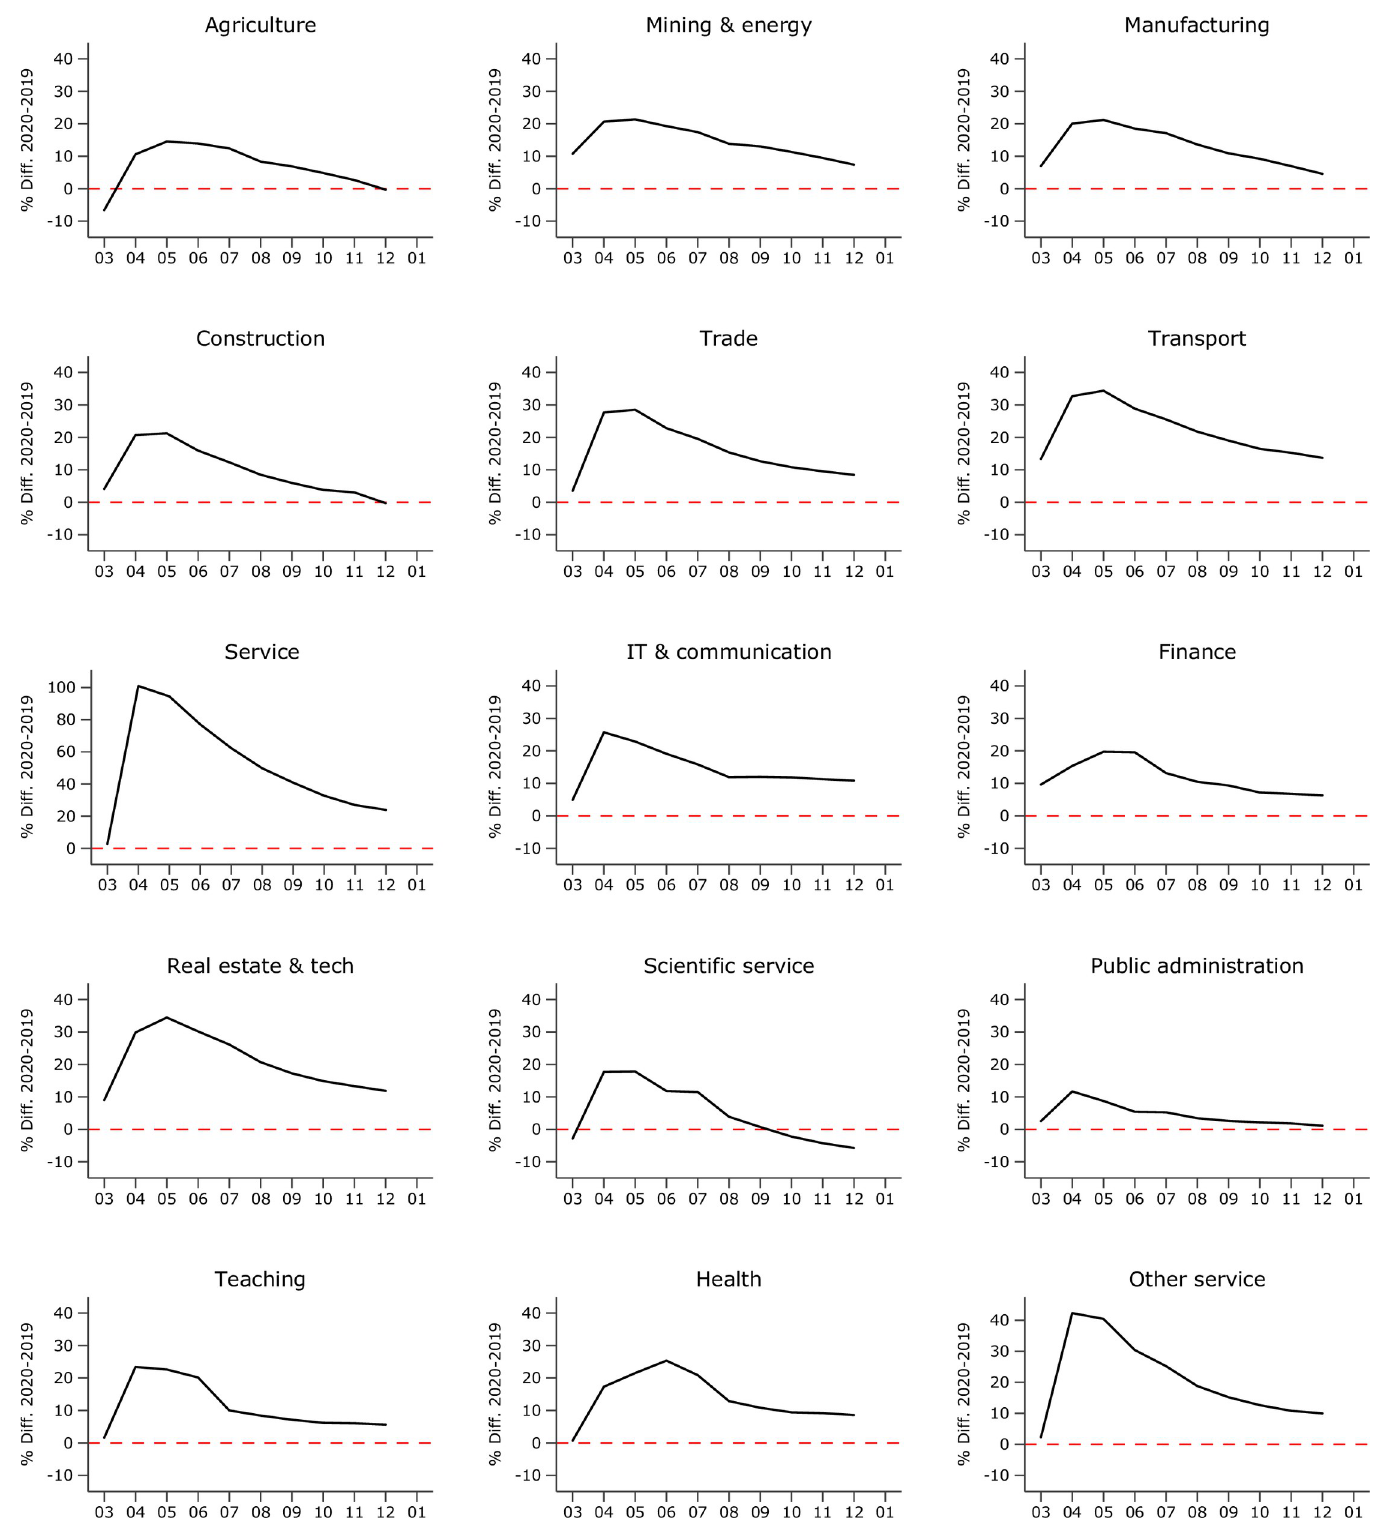
Fig 1. Economic pressure across industries and time. Note: Fig reports the cumulative difference in layoffs between 2020 and 2019 in percent as reported by the official statistics. Industry definition following Federal Office of Statistics (2021a). Source: Federal Employment Agency [3], own calculations.